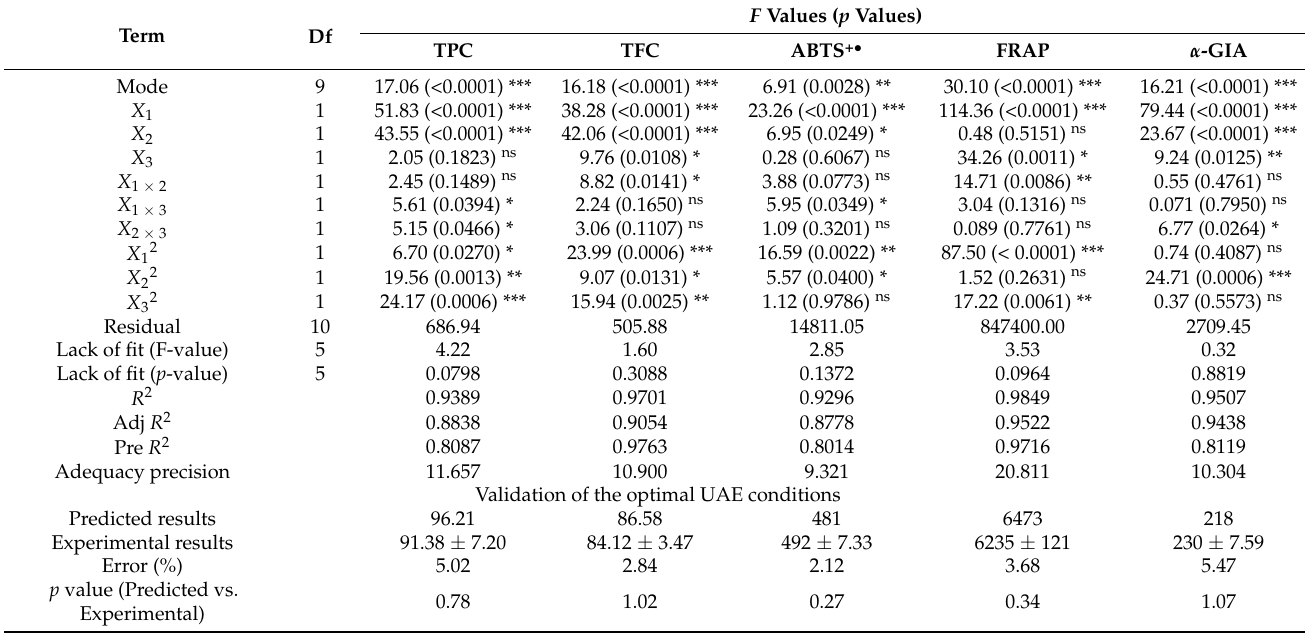
Table 3. Analysis of the variance of the fitted second-order polynomial models and validation of the responses under the optimal